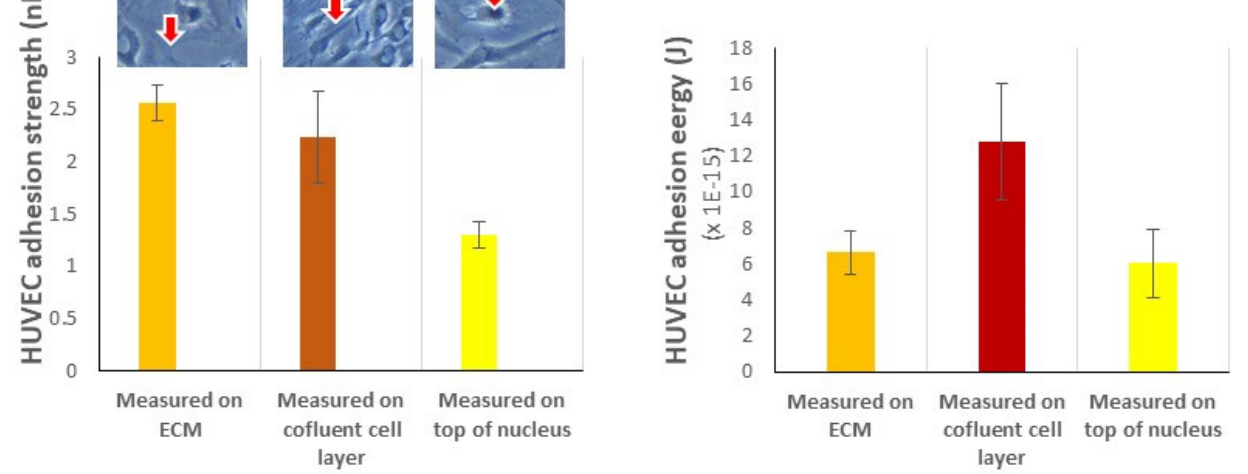
Figure 4. Cell-cell interaction strength measured in three positions (ECM, arbitrary point of confluent layer, top of nucleus) of confluent HUVECs monolayer. The data represent the mean ± SD (n = 4). Red arrows represent the typical positions at which the force measurements were done.